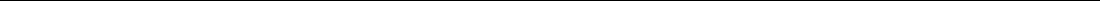
Fig. 4 Acute oxidative stress causes oxidation of predominantly metabolic and mitochondrial proteins. a Density scatterplot displaying log 2 median peptide oxidation ratios vs. peptide intensity in Fh1 fl / fl cells treated with 500 µ M hydrogen peroxide for 15 min compared to untreated cells. Every square represents a unique peptide; colour scale of the density of the data points in the corresponding region is indicated on the right. Highlighted green circles are signi fi cantly oxidised (positive values) or reduced (negative values) peptides. Gene names of corresponding peptides are displayed for the most signi fi cantly oxidised or reduced peptides. b Scatterplot displaying log 2 median peptide oxidation ratios vs. peptide intensity in Fh1 fl / fl cells treated with 500 µ M hydrogen peroxide for 15 min compared to untreated cells. Every symbol represents a unique peptide, with legend indicated. Coloured circles represent peptides of which the cysteine residue has a Feature Key annotation in the UniProt database; squares represent those without this annotation. Signi fi cantly oxidised (positive values) or reduced (negative values) cysteine peptides within the annotated group are highlighted with their corresponding gene name. Enriched c GO biological process (GOBP), d molecular function (GOMF), e and cellular compartment (GOCC) categories within signi fi cantly oxidised or reduced proteins compared to all proteins detected. a – e Based on four independent experiments, single